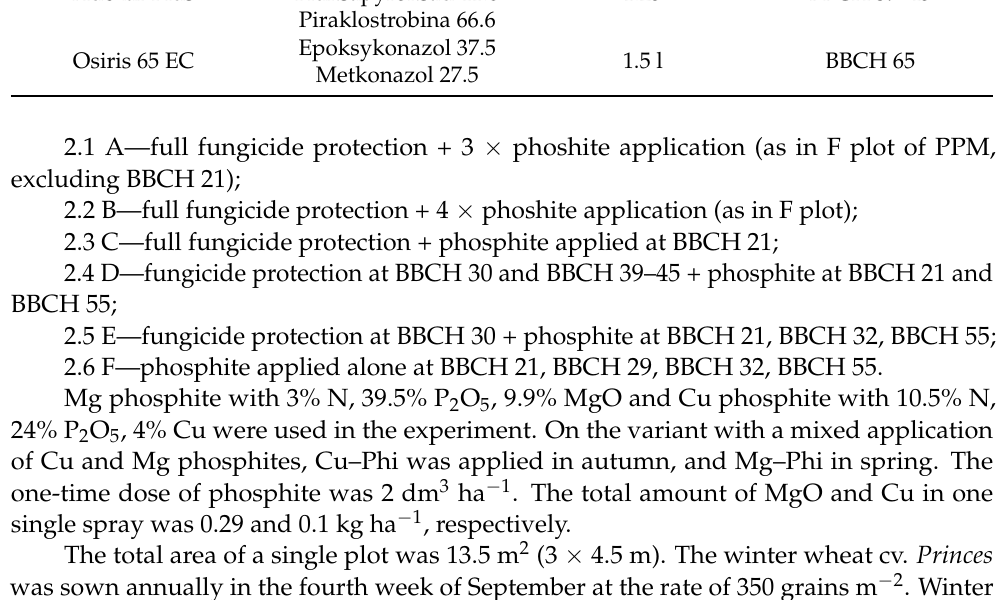
Table 2. Specification of organic fungicide composition and application dates. Fungicide Capalo 337.5 SE Adexar Plus Osiris 65 EC